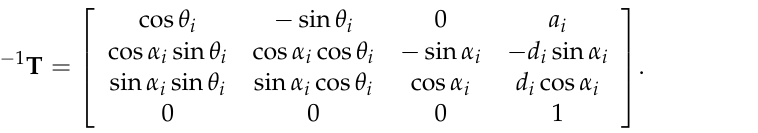
axis. According to the D–H method, the general transformation formula is as follows: